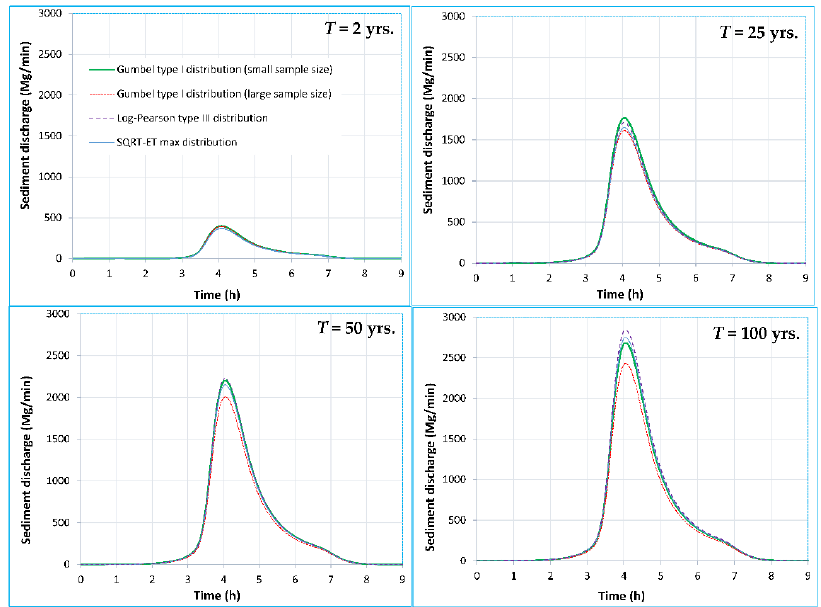
Figure 12. Total outlet sediment graphs for the study basin. T = 2, 25, 50, and 100 years.